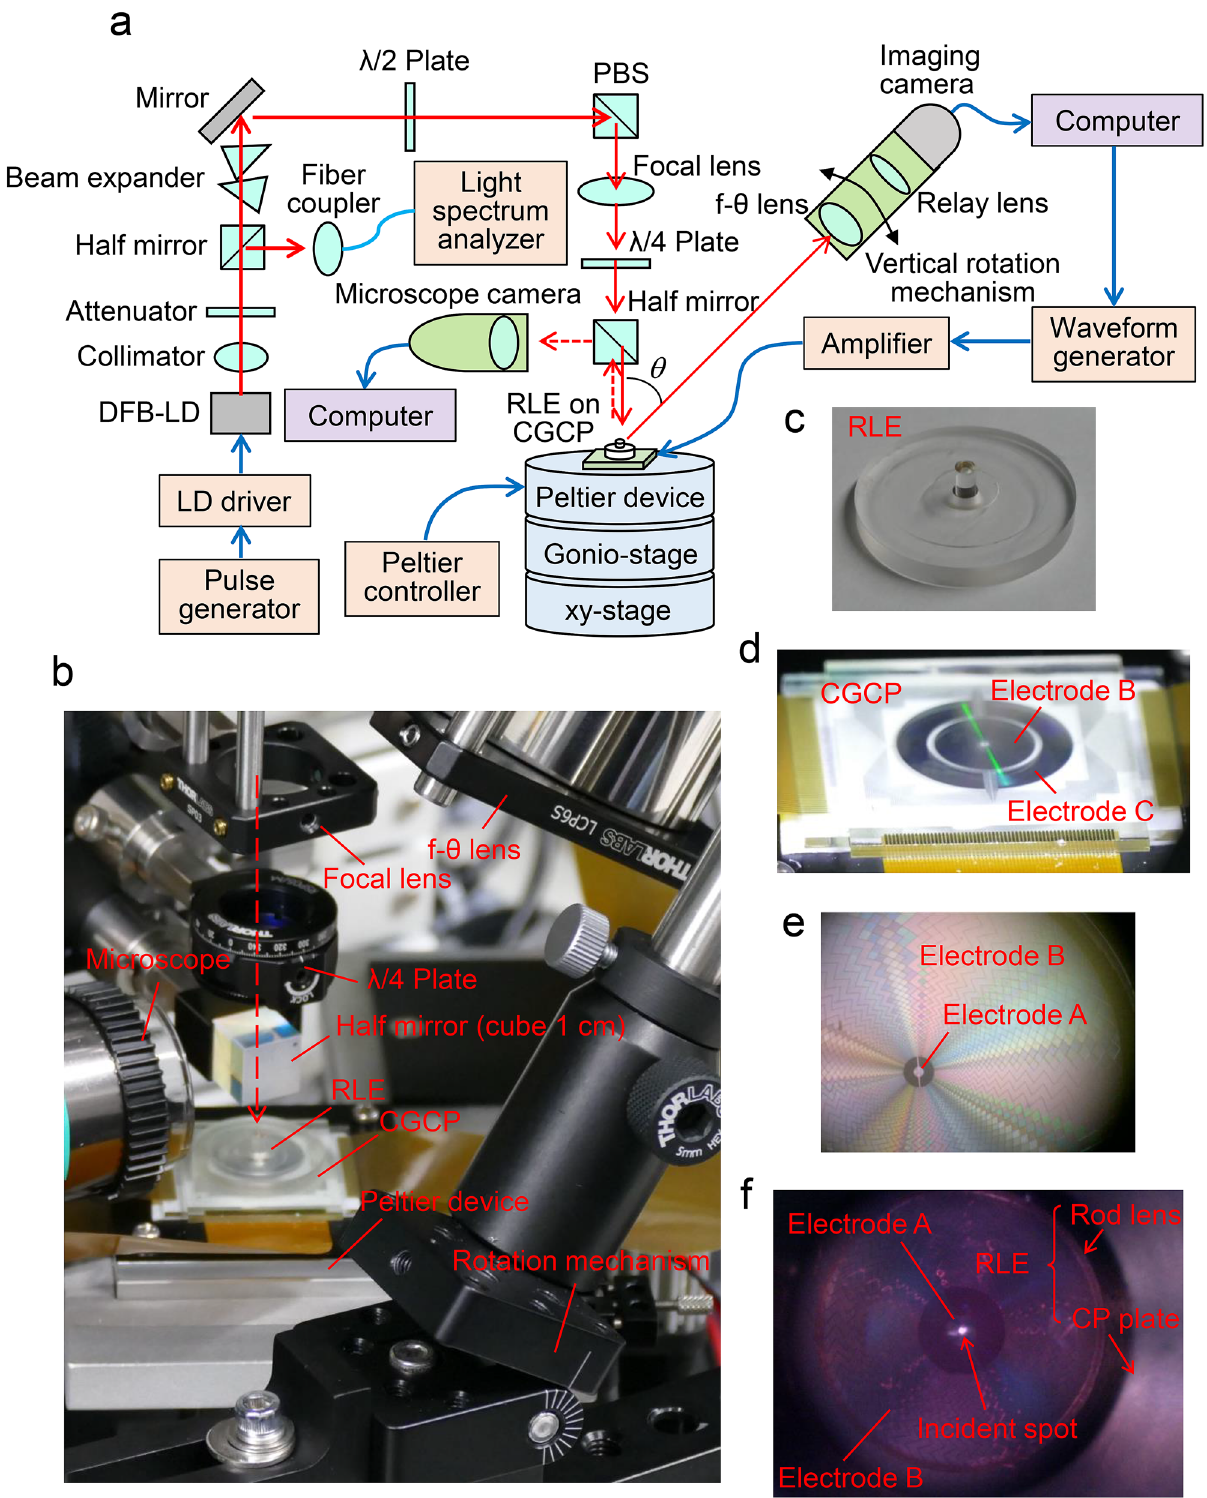
Figure 4. Experimental system for observation of scanning beams. ( a ) Configuration diagram of the experimental system. Light radiated from coupler C is converted from rotation at a constant angular velocity to a linear uniform motion by an f-θ lens and is observed using an imaging camera. ( b – d ) Perspective photographs of a portion of the experimental system, the RLE, and the CGCP. ( e ) Photograph for a central surface of the CGCP under LC control, with RLE removed. ( f ) Observation photograph of a light spot incident to the surface of the CGCP using a